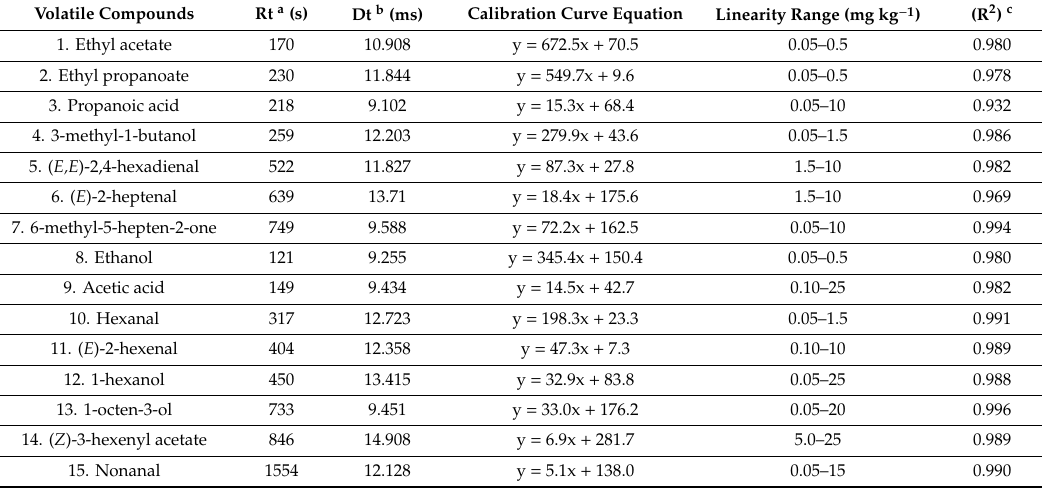
Table 1. Parameters considered for evaluation of the linearity of the volatile compounds in standard mixtures SMA (from compound 1 to compound 7) and SMB (from compound 8 to compound 15). The compounds are arranged by retention time in the respective SMA and